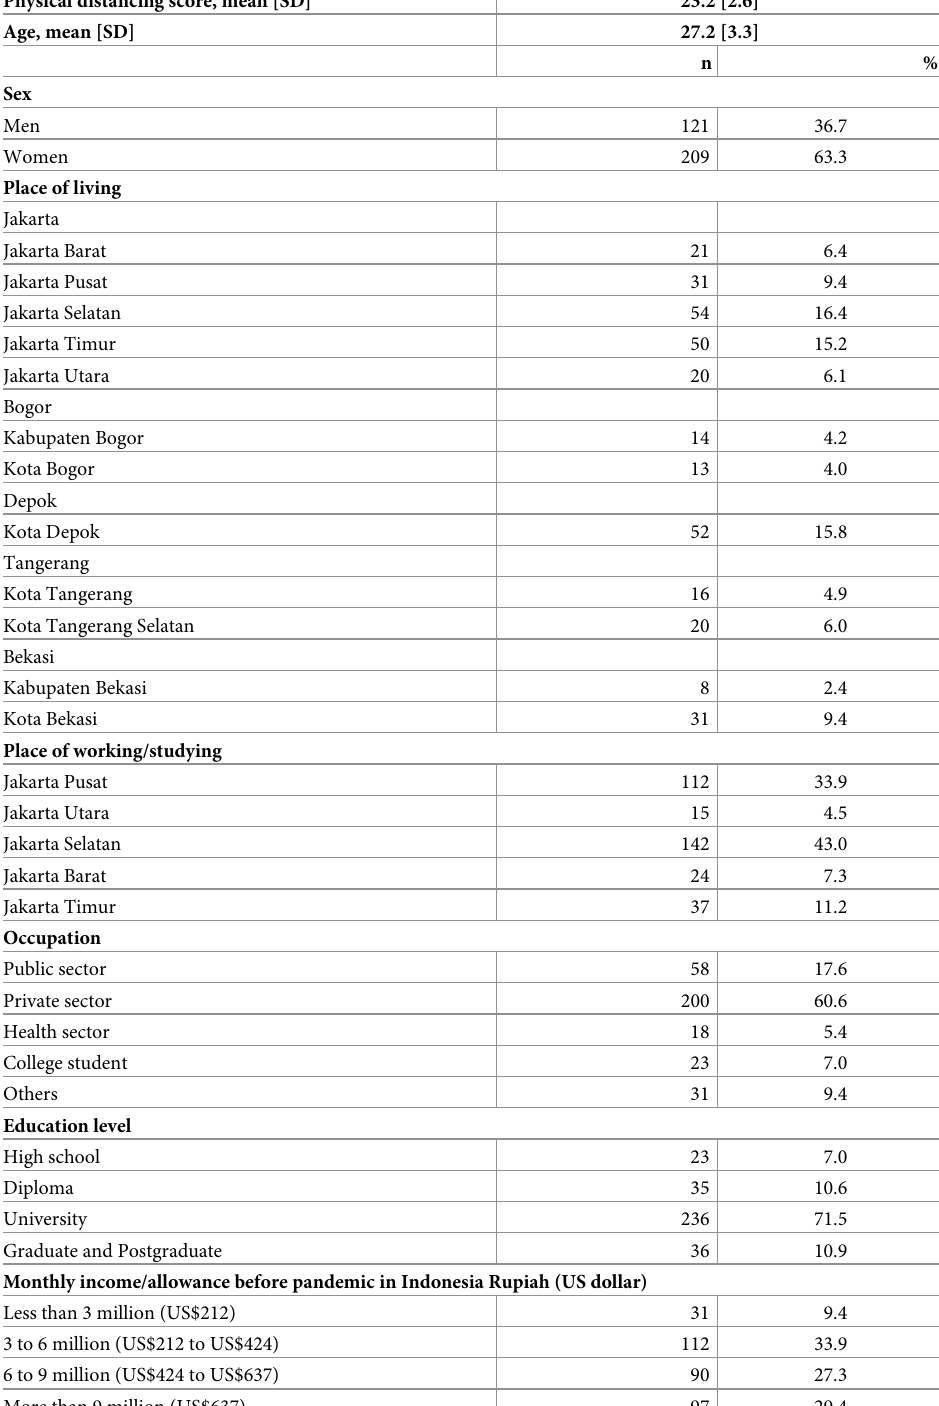
Table 1. Descriptive statistics of sociodemographic characteristics and physical distancing compliance scores of 330 young